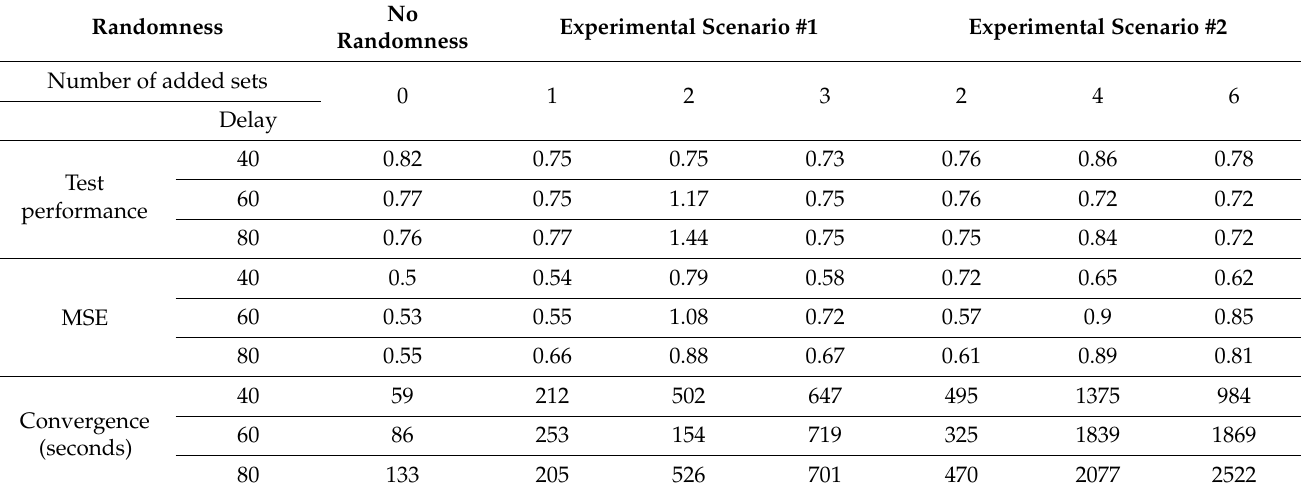
Table 14. Prediction results for added noise and input delay length variation.